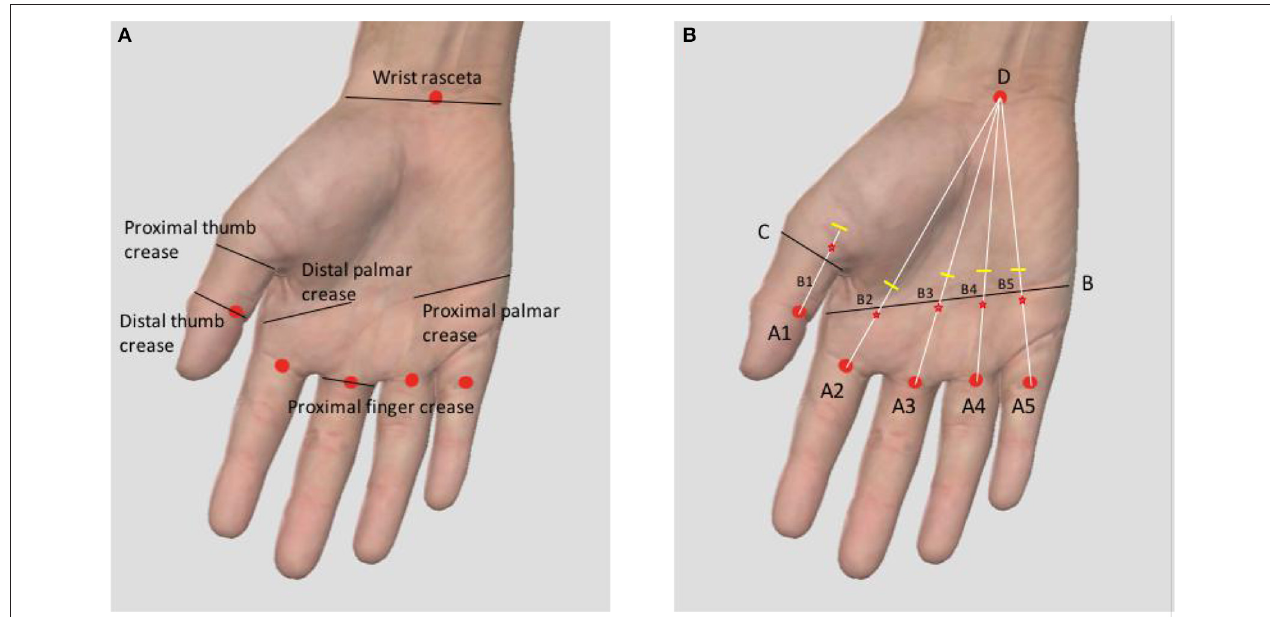
FIGURE 3 | (A) The anatomical landmark of entry point. (B) The marking method of the entry point (Triggering thumb: A straight line paralleling to the thumb from the midpoint A1 of the distal thumb crease is drawn. The line C is the transverse line of proximal thumb crease. B1 is the intersection point of A1 parallel line and C line. The entry point is + 0.5mm of B1 proximally. Triggering finger: A connection line is drawn between the midpoint of the proximal finger crease (A2 ∼ A5) and D (the midpoint of wrist rasceta). Line B is drawn between the distal and proximal palmar creases. B2 ∼ B5 are the intersection points of lines B and line AD. The entry point is − 0.5mm of B2 ∼ B5 distally).